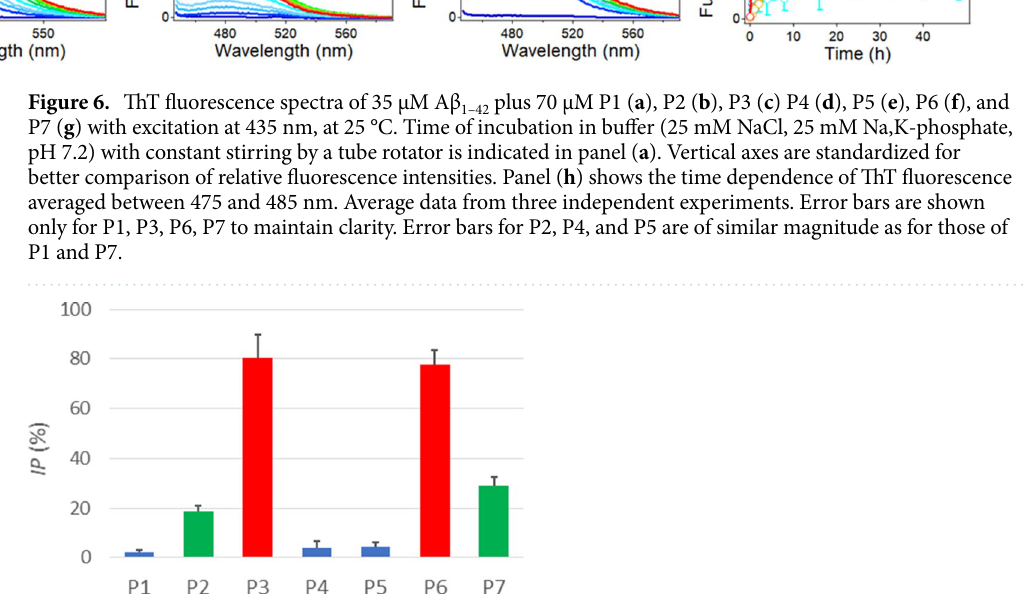
Figure 7. Inhibition percentages for P1 through P7 calculated based on ThT fluorescence data (Figs. 4, 5, 6) averaged between 32 and 48 h of incubation of Aβ 1–42 alone and with each peptide fragment at twofold molar excess in buffer (25 mM NaCl, 25 mM Na,K-phosphate, pH 7.2). Statistical difference between bars of different colors is significant ( p < 0.01). Difference between bars of same color is less significant or insignificant: for blue bars, p values vary between 0.113 and 0.851, for green bars p = 0.0163, and for red bars p =